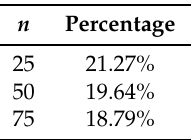
Table 6. Percentage of samples that presented convergence problems.